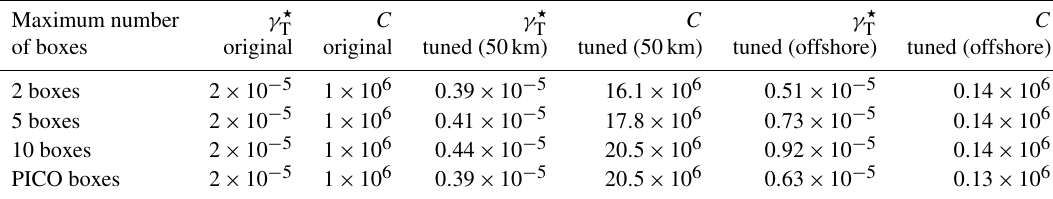
Table 8. Comparison between original (from Reese et al., 2018a) and best-estimate parameters tuned over the full 35 ice shelves and 127 years for the box parameterisation for the different setups, using heterogeneous